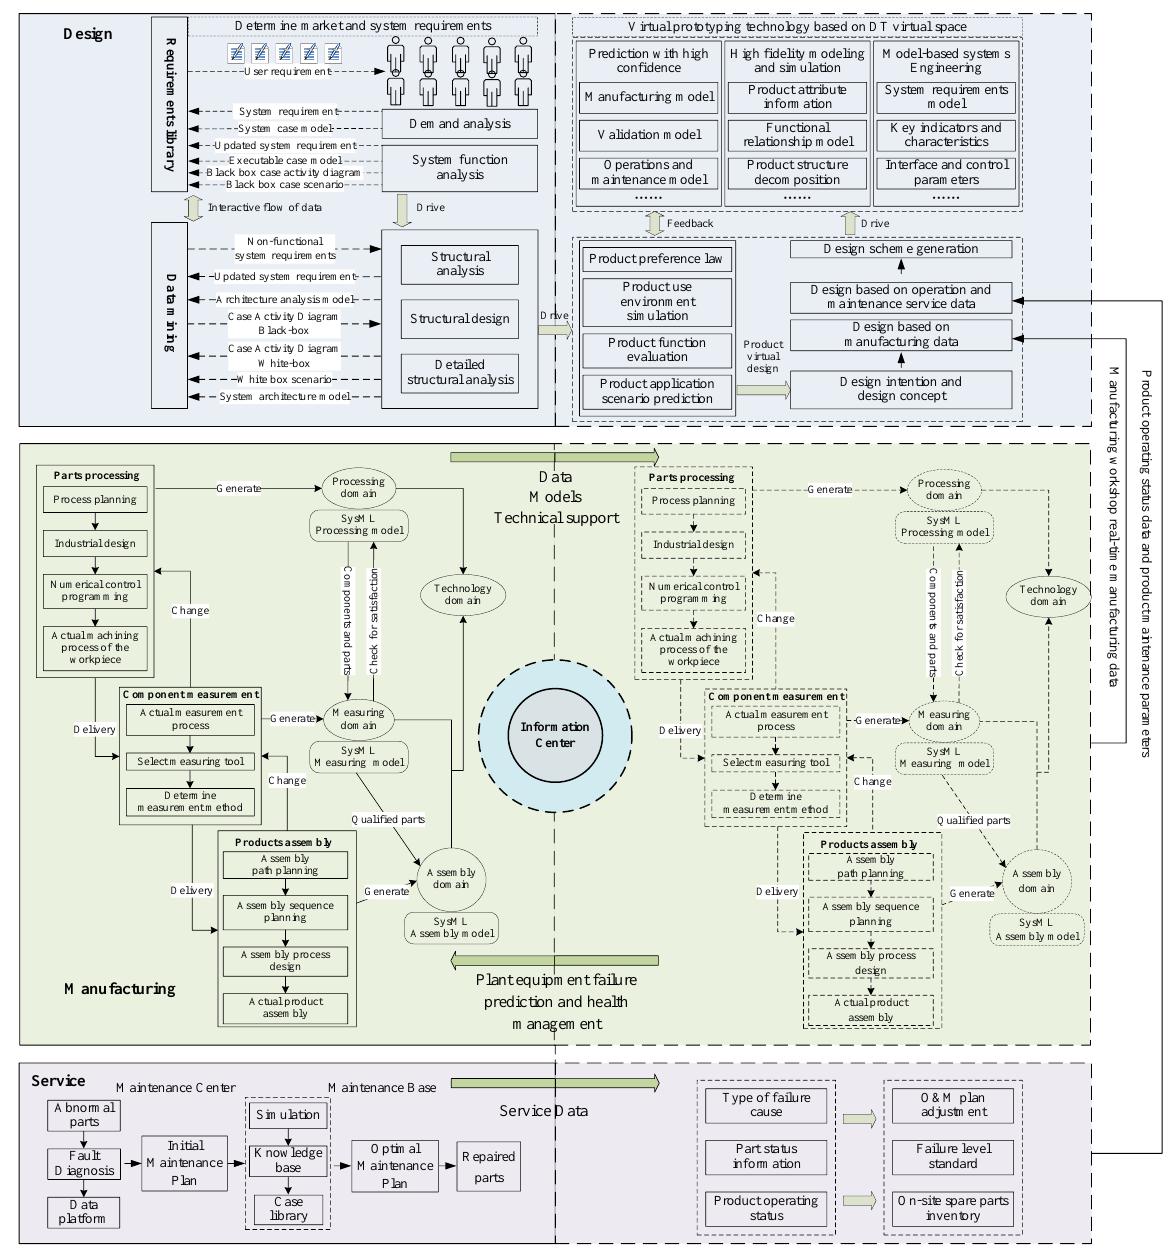
Figure 1. DMS-DT integration